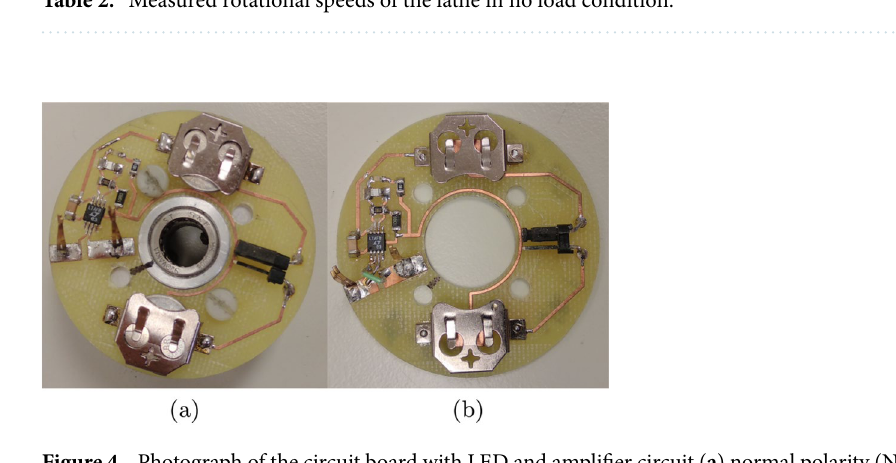
Figure 4. Photograph of the circuit board with LED and amplifier circuit ( a ) normal polarity (NP), ( b ) inverted polarity